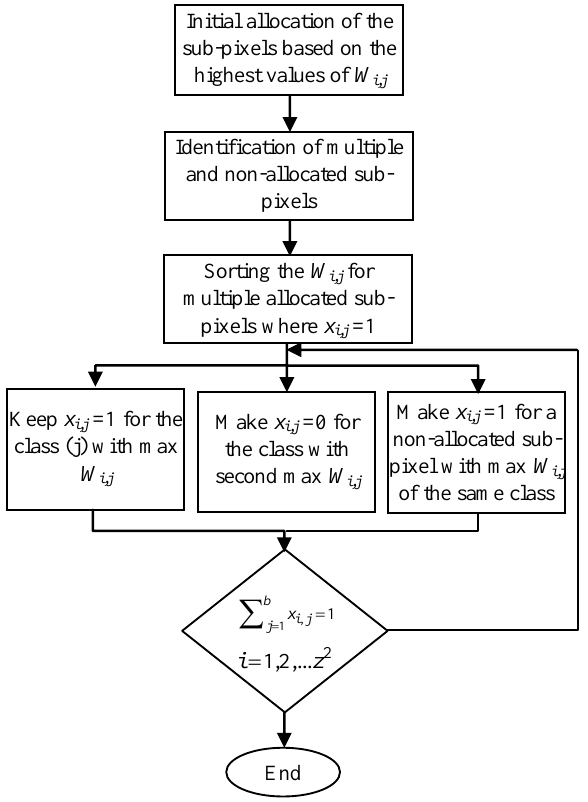
Figure 5. Proposed optimisation procedure of the multiple/non- allocated sub-pixels